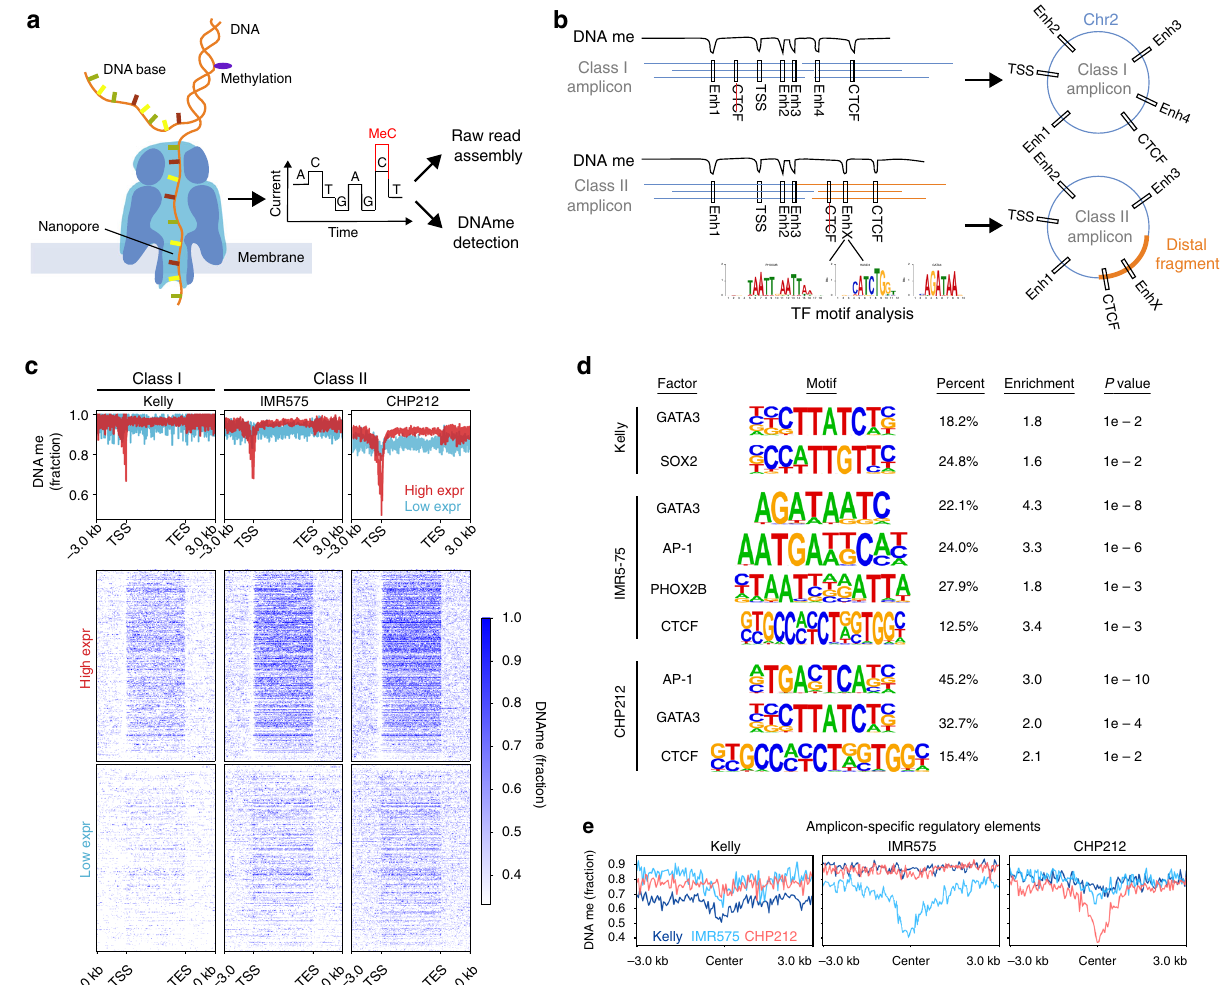
Fig. 5 Nanopore sequencing characterizes DNA methylation on MYCN amplicons. a Schematic of experimental approach. b Schematic representation of how nanopore sequencing facilitates de novo amplicon assembly and can be used to simultaneously to detect regulatory elements through DNA methylation analysis. c Composite DNA methylation signal detected using nanopore sequencing over genes expressed at high (HighExpr) vs. low levels (LowExpr). d Motif analysis based on accessibility in regulatory elements co-ampli fi ed on MYCN amplicons (unadjusted P values from one-sided binomial test against nucleotide composition-matched background sequences). e Amplicon-speci fi c methylation pattern detected in three neuroblastoma cell lines (Kelly, IMR-5/75, CHP-212) using nanopore sequencing-based DNA methylation